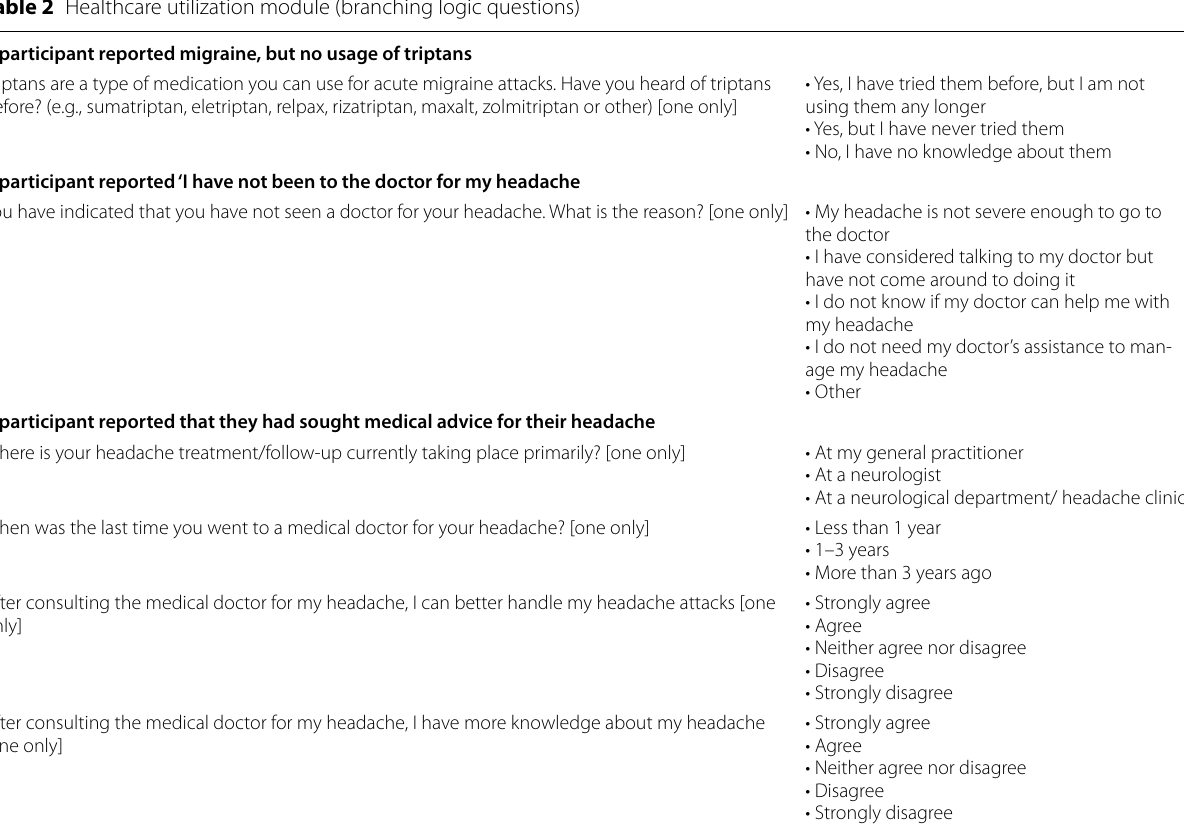
Table 2 Healthcare utilization module (branching logic questions) If participant reported migraine, but no usage of